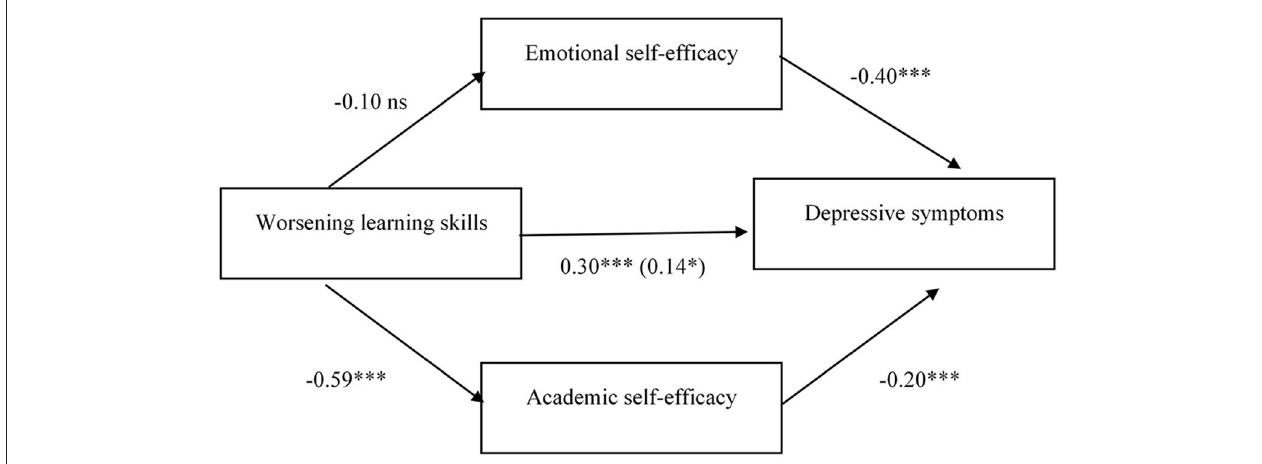
FIGURE 3 | Standardized regression coefficients (beta) for the relation between worsening in learning skills and depressive symptoms as mediated by emotional and academic self-efficacy. * p < 0.05; ** p < 0.01; and *** p < 0.001. In parenthesis the standardized regression coefficient between the independent variable and the dependent variable controlling for the mediator Gender beta = − 0.21***. R 2 = 0.35; F (4, 291) = 38.65, p <